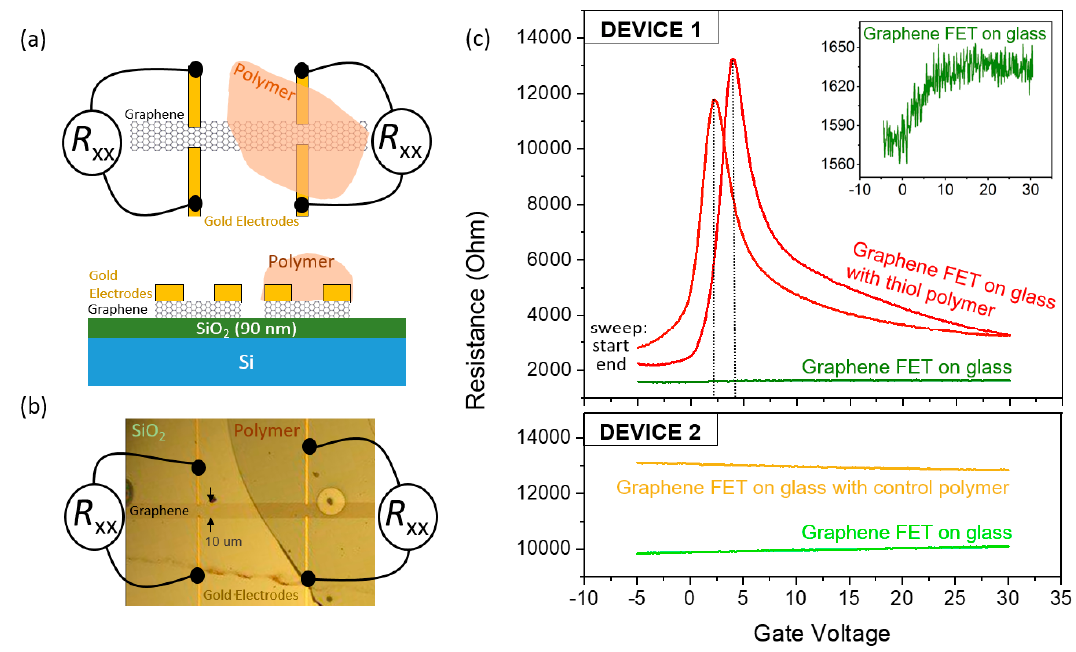
Figure 7. ( a ) Graphene field effect transistor (GFET). A graphene flake is structured on a SiO 2 /Si substrate, and gold electrodes patterned on top, to act as electrical contacts for measurements. Part of the GFET is locally covered with a cured piece of thiol-polymer, as sketched in the top and side views. The p-doped silicon substrate acts as a back gate, which is electrically isolated from the graphene Hall bar by a layer of SiO 2 (bottom panel). The upper part of the Hall bar is covered by polymer whereas the lower part remains exposed. ( b ) Photo of an actual device, where the area on the right side is darker due to polymer deposited on top. ( c ) Measurement of the two-terminal resistances of the GFET device as a function of a gate voltage. The upper graph (Device 1) shows the results for one of the measured devices. The green line corresponds to the graphene “at-air”. The red lines correspond to the measurement on the graphene covered with the thiol-polymer, for a sweep from − 5 V to 30 V, and from 30 V to − 5 V, as marked in the graph. The lower graph (Device 2) shows the results of a similar experiment performed in another different graphene FET device, where instead of the thiol polymer, a layer of a non-hygroscopic polymer (Ormostamp) is used to cover the graphene, as control experiment.